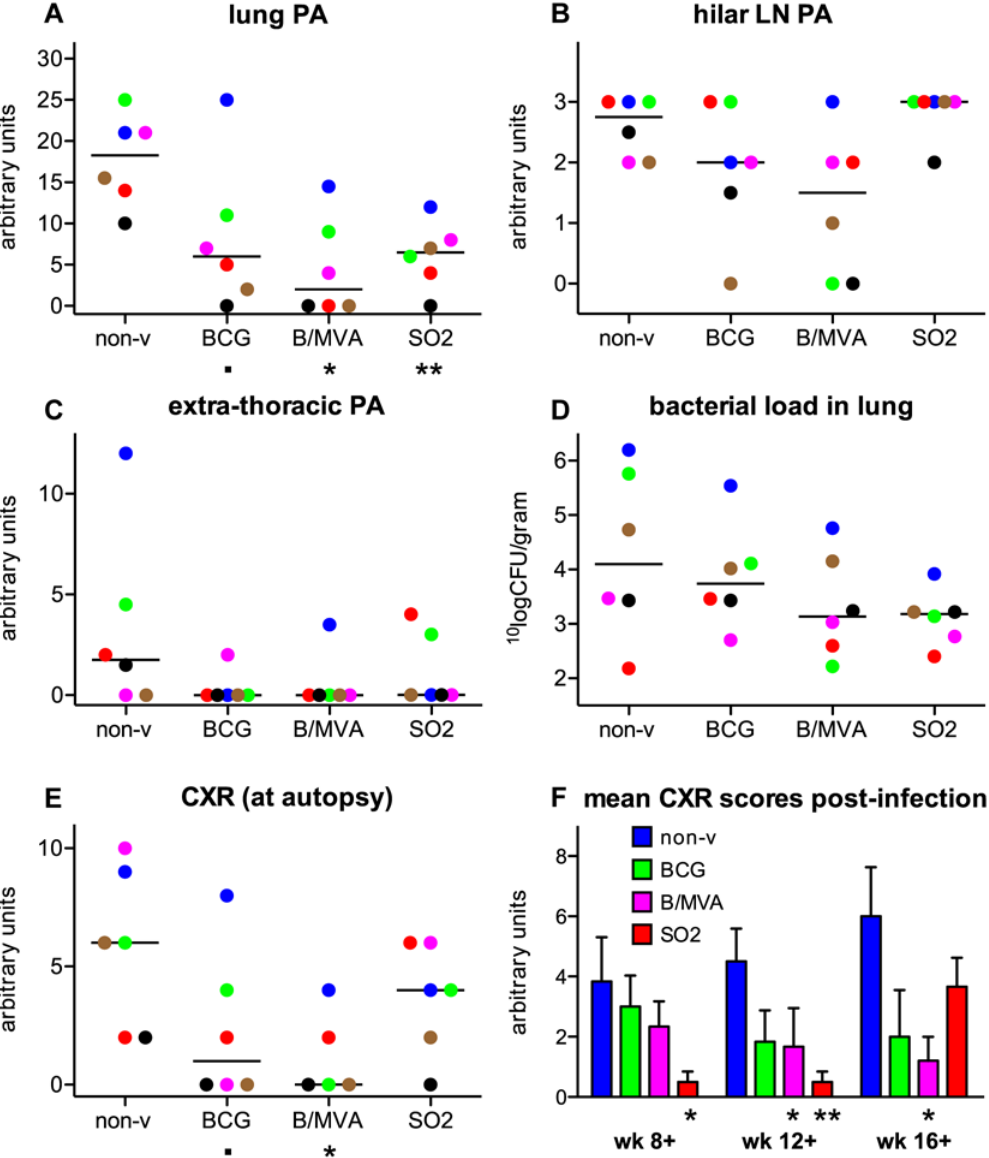
Figure 3. Evaluation of gross pathology, radiology and bacterial loads upon infectious challenge. Individual scores per treatment group and group median values are plotted for macroscopic lung pathology (PA) (A), hilar LN involvement (B), extra-thoracic PA (C), bacterial burden in the lung (D), and chest X-ray (CXR) scores at autopsy (E). Kinetics of TB disease are reflected by mean CXR scores ( + standard error of the mean) per treatment group in time (F). BCG/MVA shows protection by significantly reduced lung lesion scores and CXR scores at autopsy compared to non- vaccinated controls, and by reduced hilar LN involvement and CFU in the lung (not significant). SO2 in comparison to non-vaccinated controls shows significant protection by reduced lung lesion scores and delayed kinetics of TB by CXR in time, and by reduced CFU in the lung (not significant). For legends of colouring and symbols see legend to Figure 2. For BCG/MVA treatment CXR at autopsy n=5; one recording censored due to technical error.